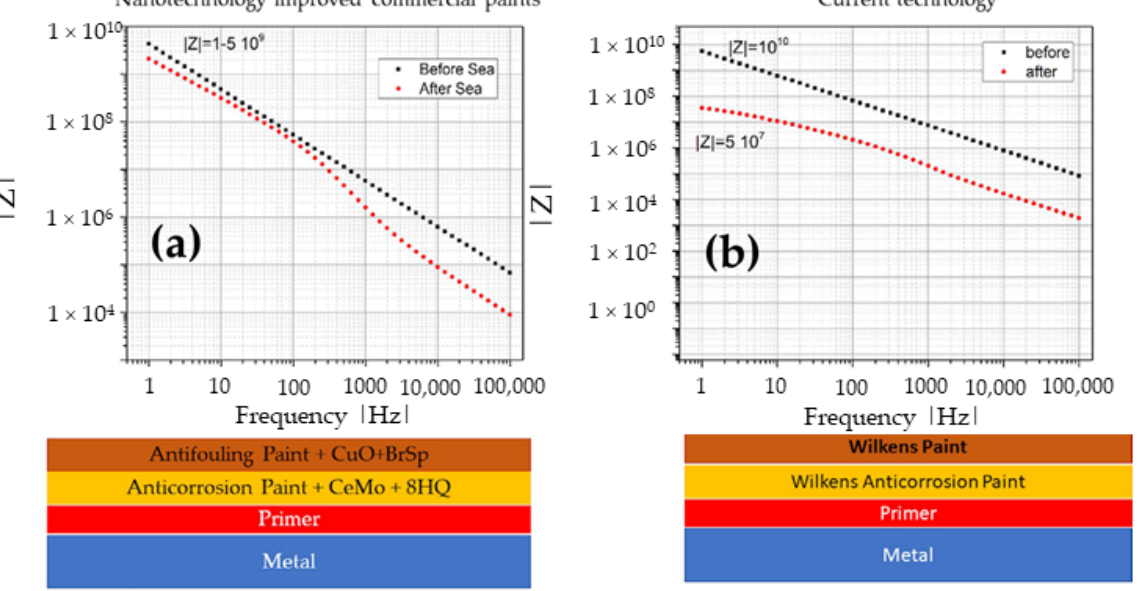
Figure 5. FRA of paints (( a ) nanocontainer technology and ( b ) commercial paint) before and after immersing the samples in seawater for three paints.